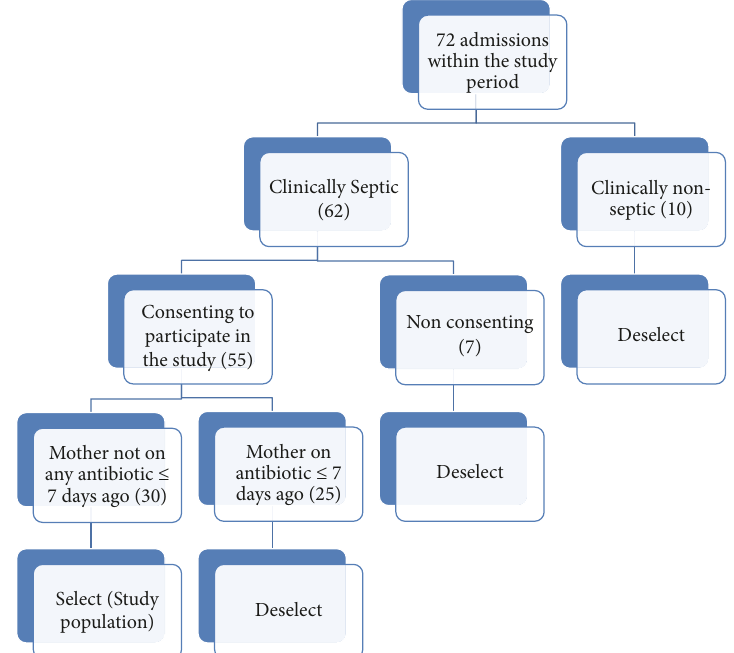
Figure 1: Selection criteria.